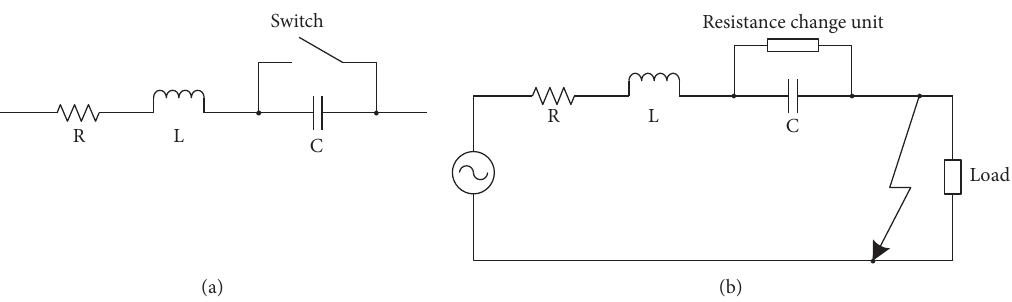
Figure 16: Fundamental diagram of the series resonance fault current limiter.